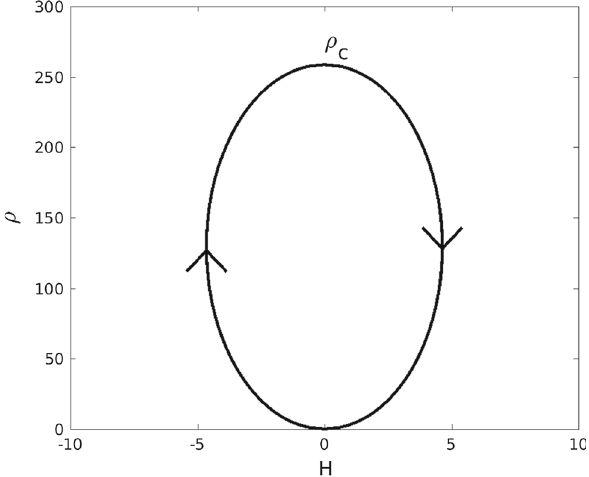
Fig. 1 Ellipse depicted by the Friedmann equation in standard LQC, and its dynamics for a non-phantom fluid or field